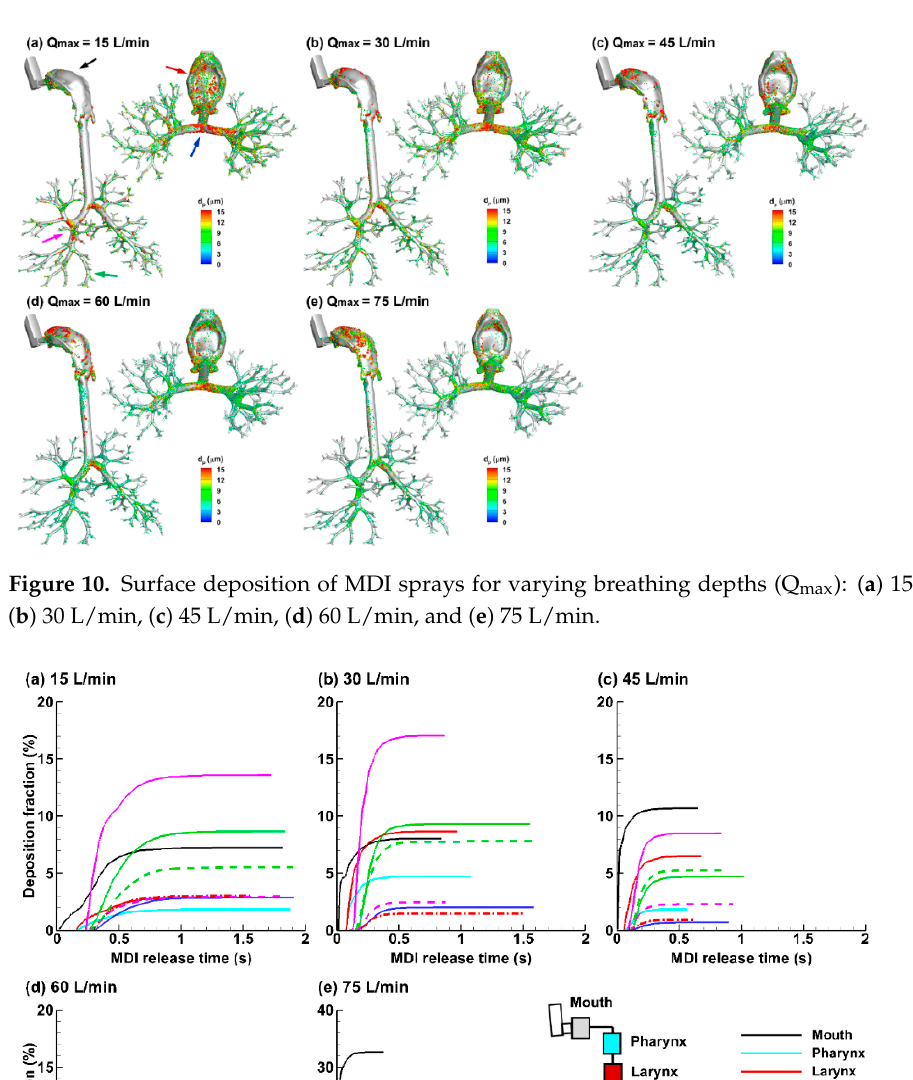
Figure 9. Mid-plane velocity contours at 100 ms after actuation with varying breathing depths (Q max ): ( a ) 15 L/min, ( b ) 30 L/min, ( c ) 45 L/min, ( d ) 60 L/min, and ( e ) 75 L/min.